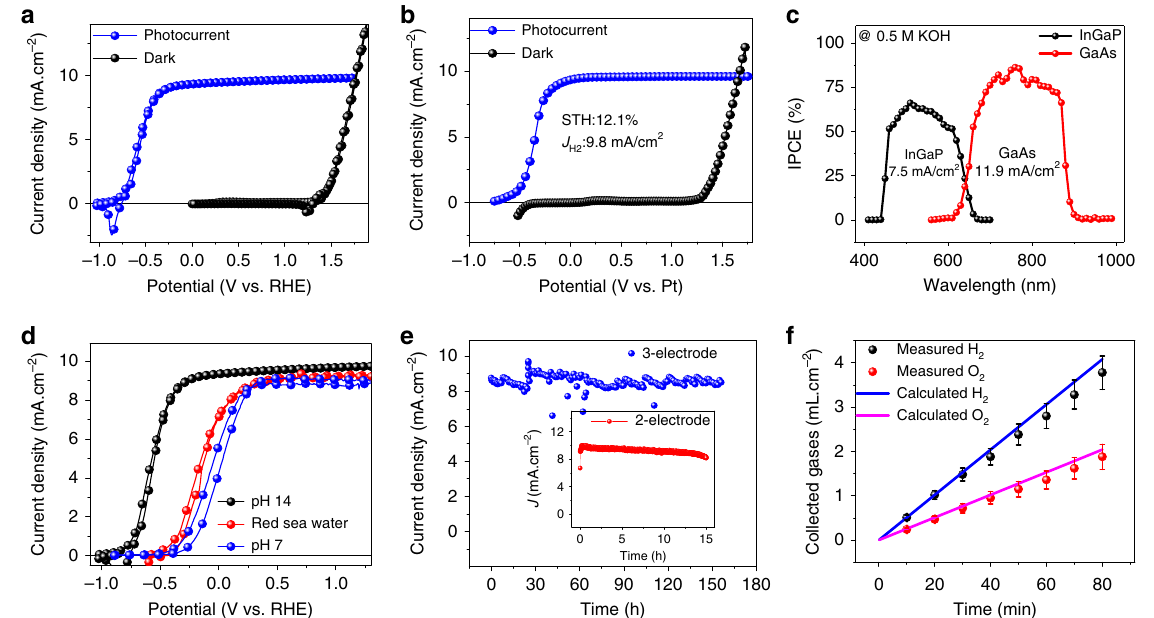
Fig. 3 Photoelectrochemical water-splitting characteristics. a CV curves of the InGaP/GaAs tandem photoanode measured under a three-electrode system in 0.5 M KOH (aq) electrolyte under one sun illumination and dark electrolysis of the Ni/p + Si. b LSV curves of the photoanode in 0.5 M KOH (aq) under one sun illumination, in a two-electrode setup. c Spectral response of the tandem photoelectrode, for which the integrated light is limiting the current densities under AM 1.5 G illumination. d CV curves of the InGaP/GaAs tandem photoanode measured under 0.5 M KOH (pH 14), 1 M Na 2 SO 4 (pH 7), and as-obtained Red Sea water (pH 8.2). e Chronoamperometry of a tandem photoanode in a 3-electrode con fi guration measured at 0 V vs. RHE under one sun illumination in 0.5 M KOH (aq), demonstrating the stability over 150 h. Inset shows the 2-electrode stability measured by short-circuiting the working and counter electrodes without any applied bias. f The measured hydrogen and oxygen as a function of time in a two-cell electrode